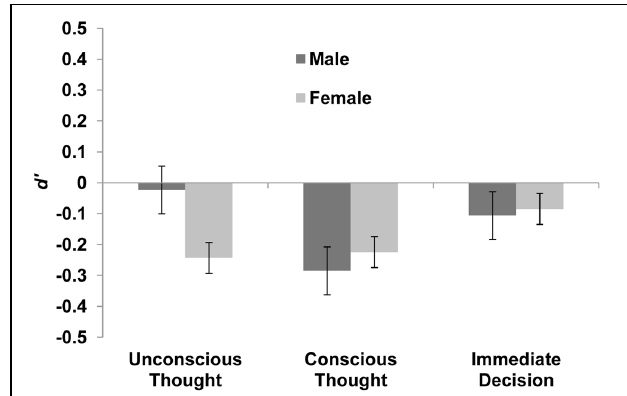
FIGURE 1 | Mean d (cid:2) of males and females in each condition of Experiment 1 with + 1/ − 1 SE